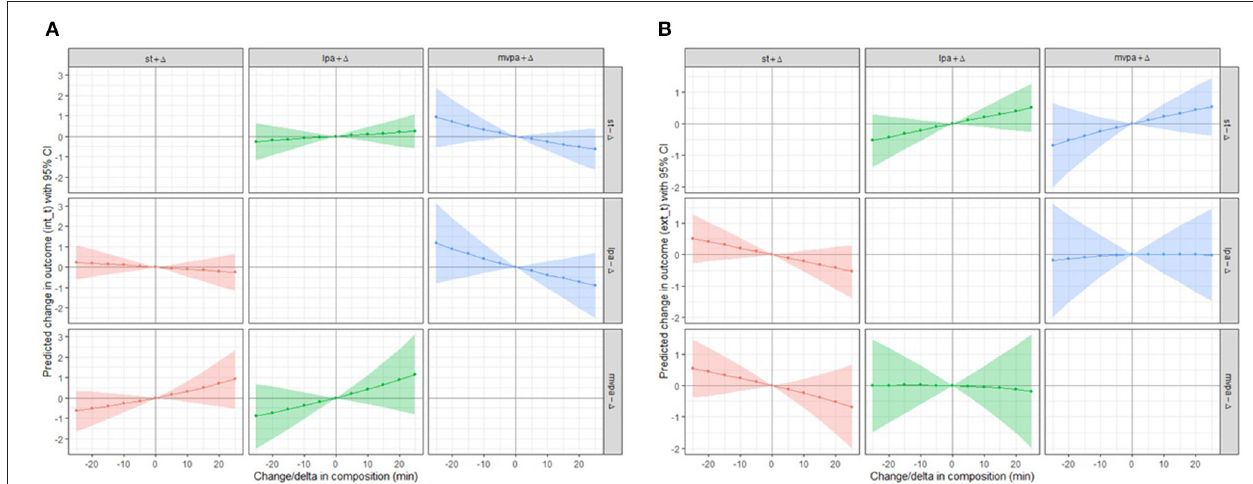
FIGURE 3 | The impact of reallocating time (5 to 25min) between movement behaviors (e.g., replacing 25min of sedentary behavior with 25min of light physical activity, while holding moderate-to-vigorous physical activity constant) on internalizing problems (A) and externalizing problems (B) .